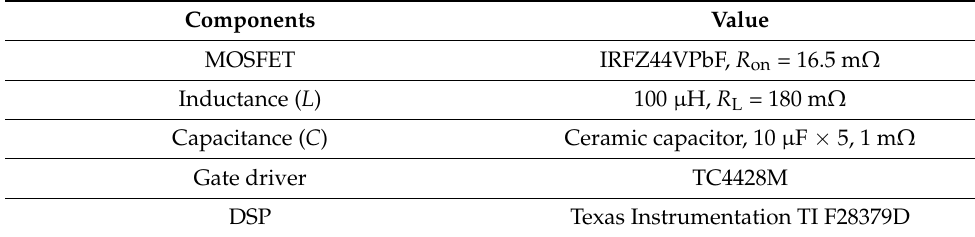
Table 4. Ratings of the component used for